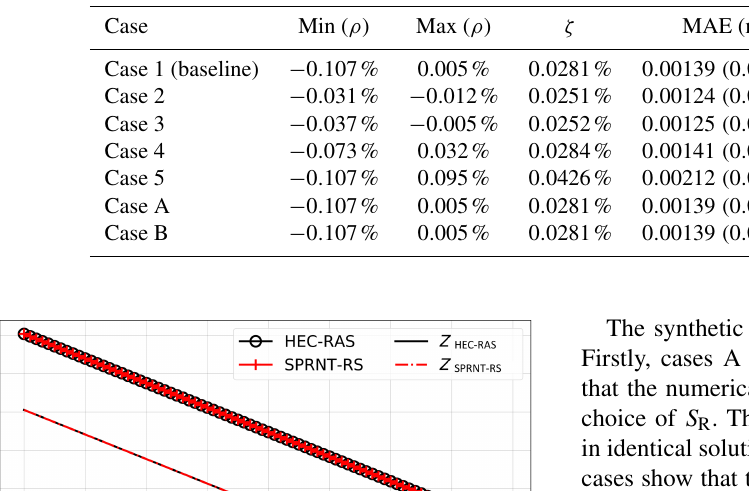
Table 5. Difference measures between SPRNT-RS and HEC-RAS using Eqs. (23)–(28) for synthetic test cases. Nondimensional MAE and RMSE are shown in parentheses.